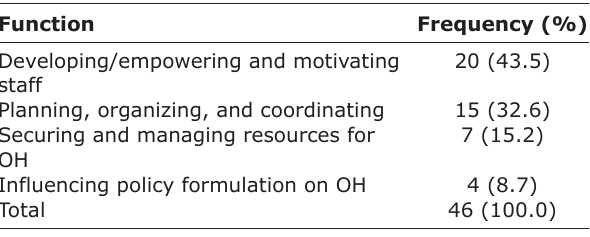
Table-9: Respondents’ views of influential leadership functions in OH